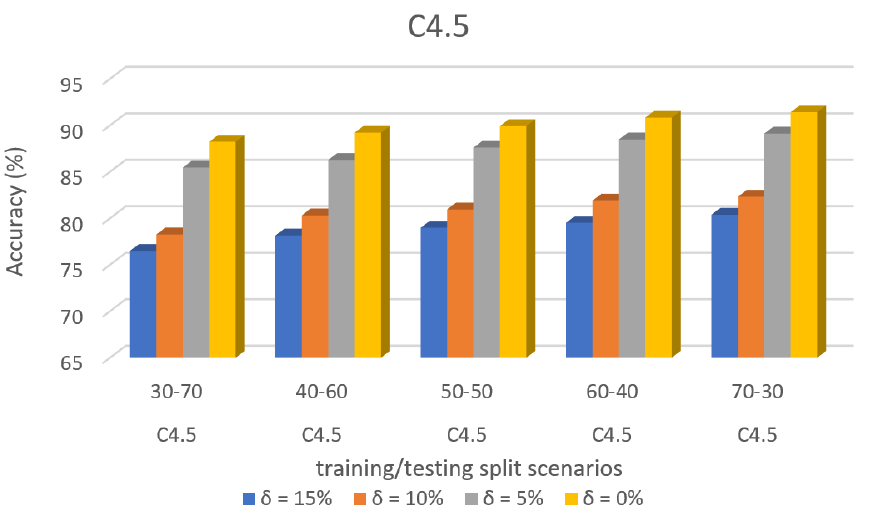
Figure 10. Accuracy prediction for Dataset 1 using the C4.5 algorithm.